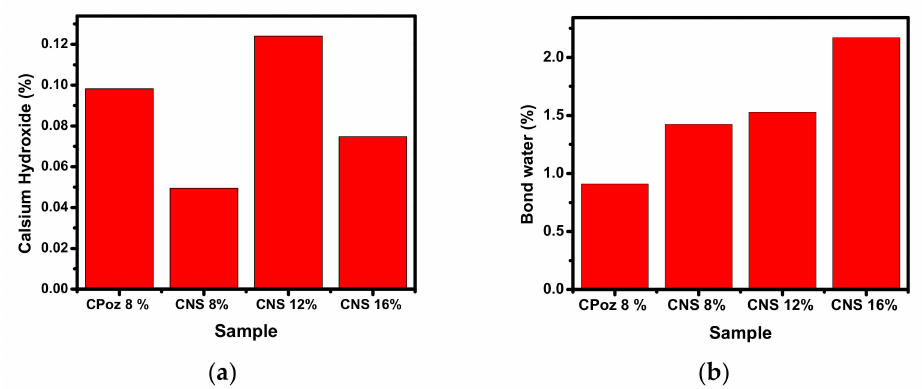
Figure 13. ( a ) Mass of calcium hydroxide, ( b ) Mass of bound